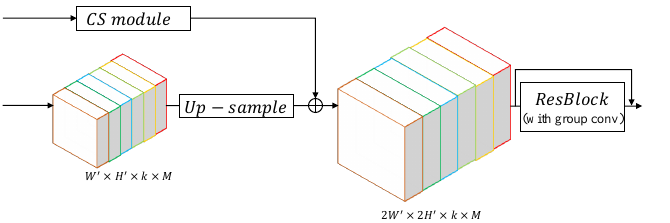
Figure 6. Details of the class-wise up-sampling (CU) block. Up-sampled features added by skip features from corresponding CS modules are sent into a Res-Block to learn feature up-sampling, in which group convolution is applied to obtain class-wise up-sampling